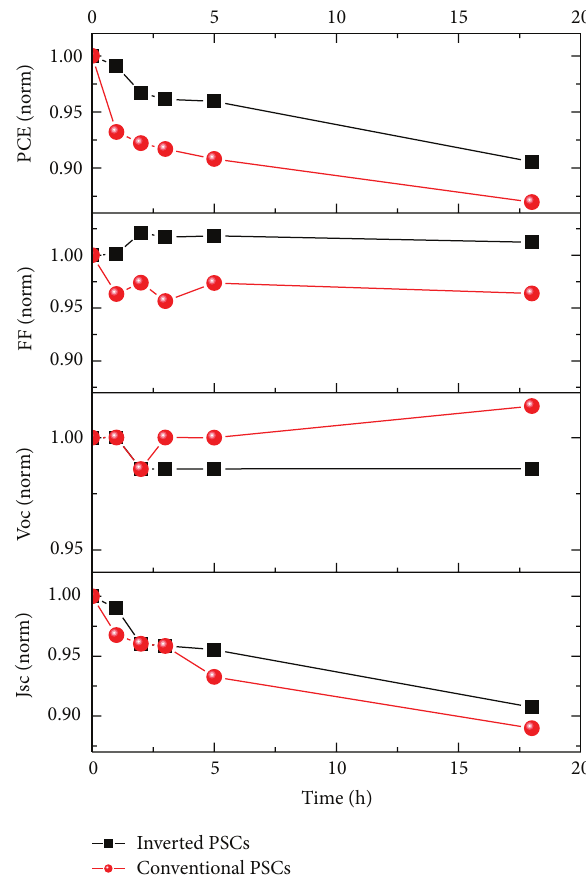
Figure 5: Normalized PCE, FF, Voc, and Jsc of conventional (red dot) and inverted (black square) solar cells at 70 ∘ C for different time. All curves are normalized to the initial